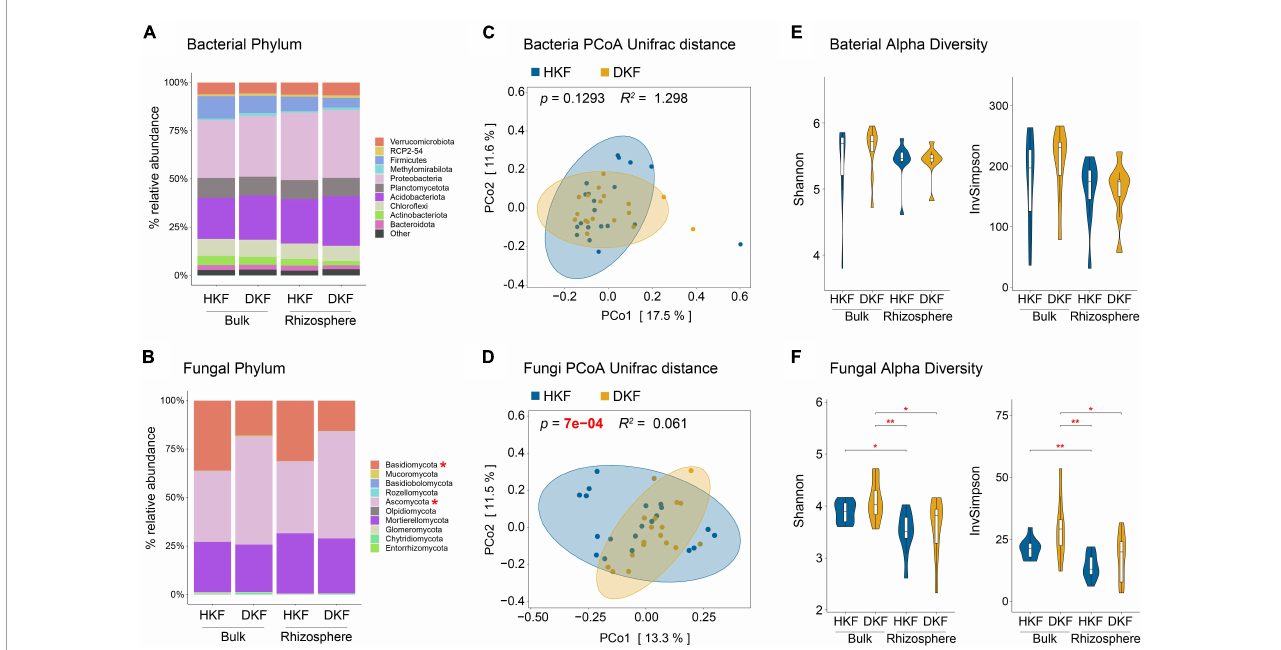
FIGURE2 Comparisons of the microbiome community structure and diversity based on the decline of Korean fir health and soil compartment. The upper panel (A,C,E) presents the analysis of the bacterial community, and the lower panel (B,D,F) presents the analysis of the fungal community. (A,B) Relative abundance of top ten dominant phyla of healthy Korean fir (HKF) and dead Korean fir (DKF) in different soil compartments. Other phyla are included as “Others”. (C,D) Principal coordinates analysis (PCoA) based on unweighted UniFrac distance and microbial diversity differences between the HKF (blue) and DKF (yellow) groups. Adonis R 2 and p -values are provided for each plot. (E,F) Shannon and inverse Simpson diversity index of the soil microbiota based on heath decline of Korean fir and soil compartment. Significance levels: * p < 0.05, ** p <